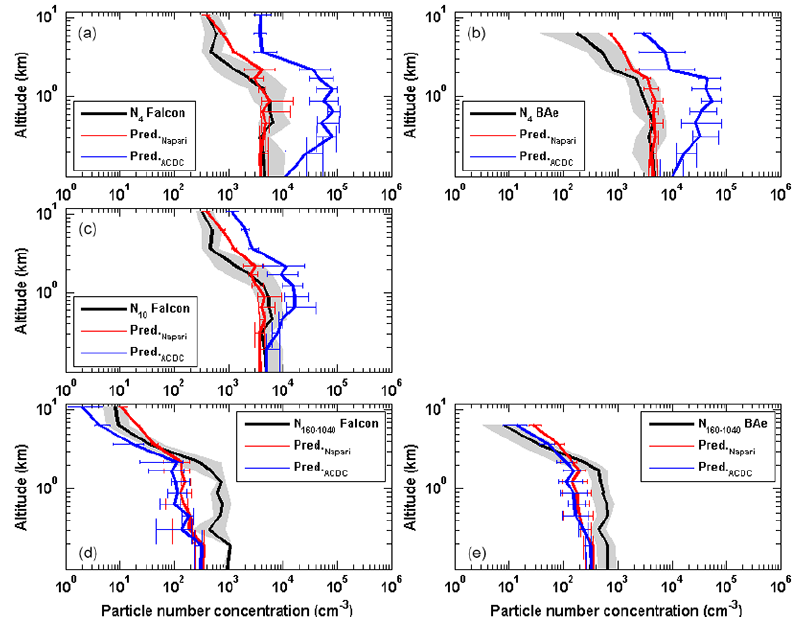
Figure 4. Vertical profiles of measured (black) and predicted (red and blue) particle number concentrations for the following size ranges: (a, b) larger than 4nm ( N 4 ) measurements collected by Falcon and BAe-146, respectively; (c) larger than 10nm ( N 10 ) measurements collected by Falcon 20; and (d, e) 160–1040nm ( N 160–1040 ) measurements collected by Falcon and BAe-146, respectively, during May 2008. Red and blue lines show the predicted particle number concentrations by the PMCAMx-UF model using ACDC-based formation rates (ACDC- TUV-DE) and scaled Napari new-particle formation scheme (Napari-TUV-DE), respectively. The lines show the median values of data points within each model layer, and the error bars and grey shading indicate the values between 25th and 75th percentiles of the model results and observations, respectively. Concentrations are given at ambient temperature and